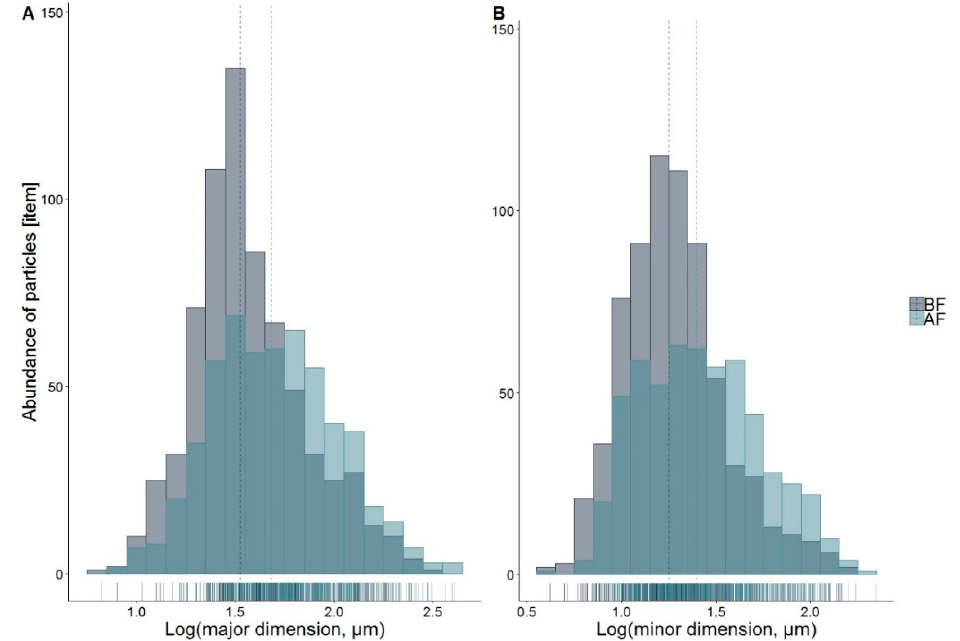
Figure 2. Particle size distribution of the MPs in wastewater before (BF, grey) and after (AF, light green) disc filter treatment by the particles’ major ( A ) and minor dimensions, ( B ) on a logarithmic scale. The dark green bars indicate overlaps between BF and AF data. The size of the bins is 0.1. The dashed lines denote the median particle dimension. The rug on the x-axis illustrates the distribution of data points.